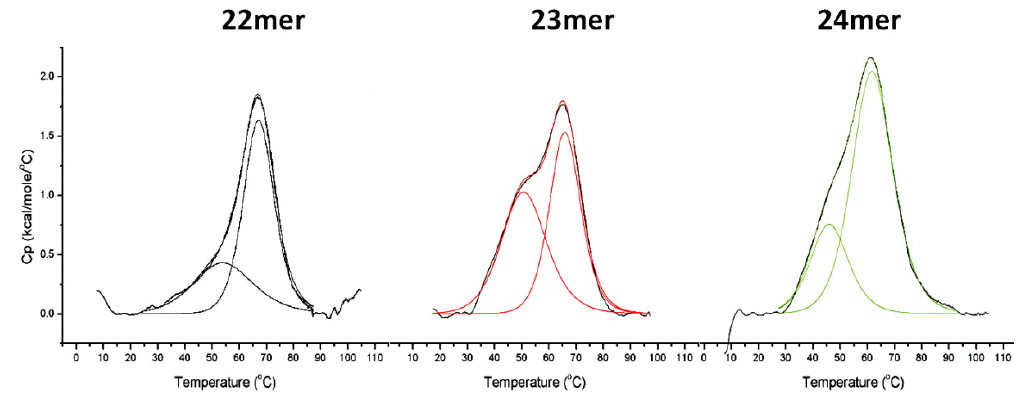
Figure 2. DSC unfolding of G-quadruplexes containing 5' base overhangs. DNA samples were prepared at 100 μ M strand concentration in 10 mM potassium phosphate (pH